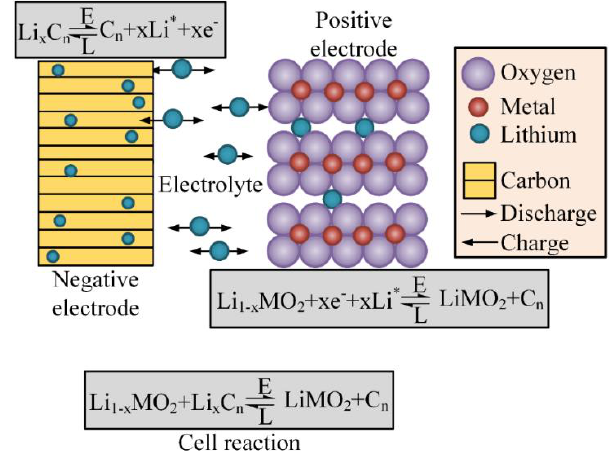
Figure 28. Chemical processes in Li-polymer cells. While charging, Li+ intercalates from the cathode to anode, passing through the electrolyte and increases the gap between the layers, increasing the cell thickness. While discharging, the reverse occurs and the cell thickness decreases [102].